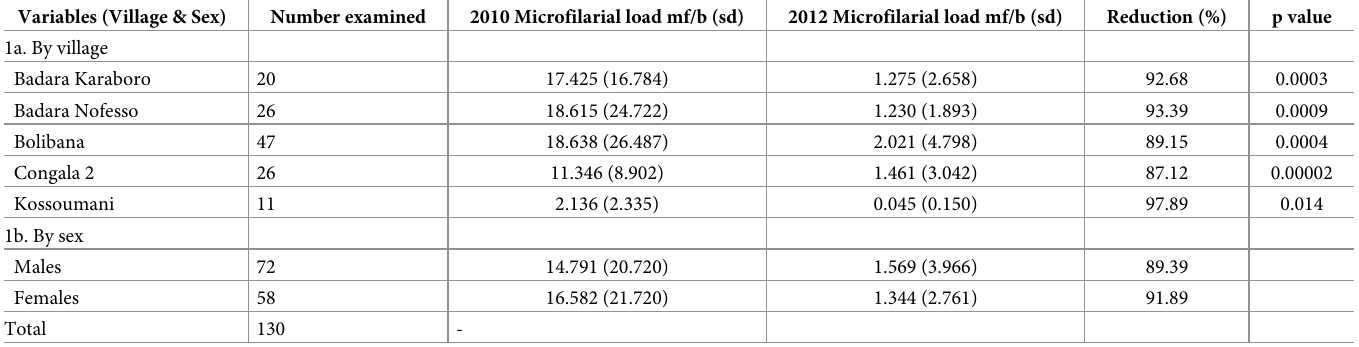
Table 1. Microfilarial Load of Participants in 2010 and 2012 by Village and by Sex.